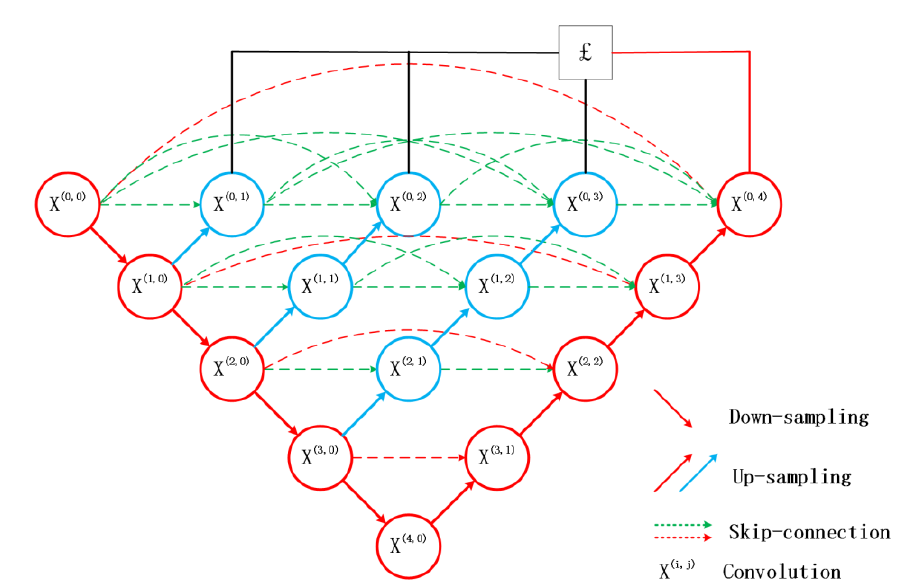
Figure 3. U-Net ++ network structure diagram.